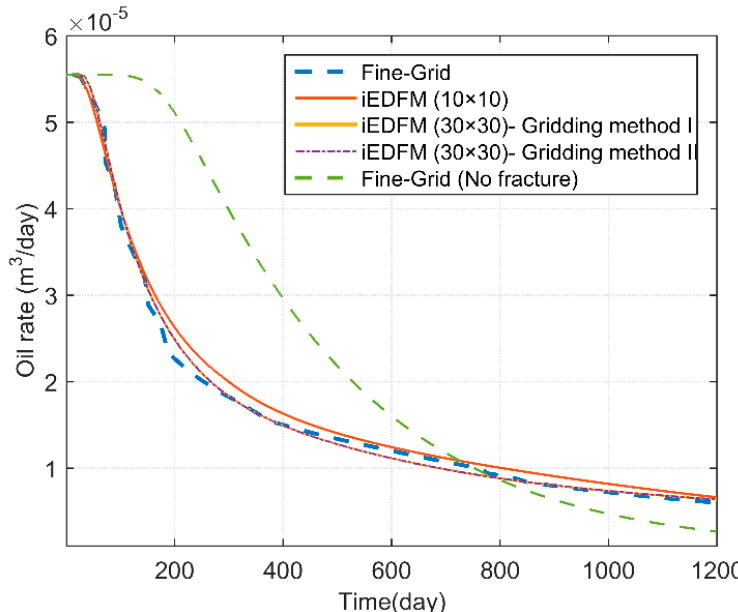
Figure 8. Comparison of oil production rate by the iEDFM/fine-grid model in Case 2.